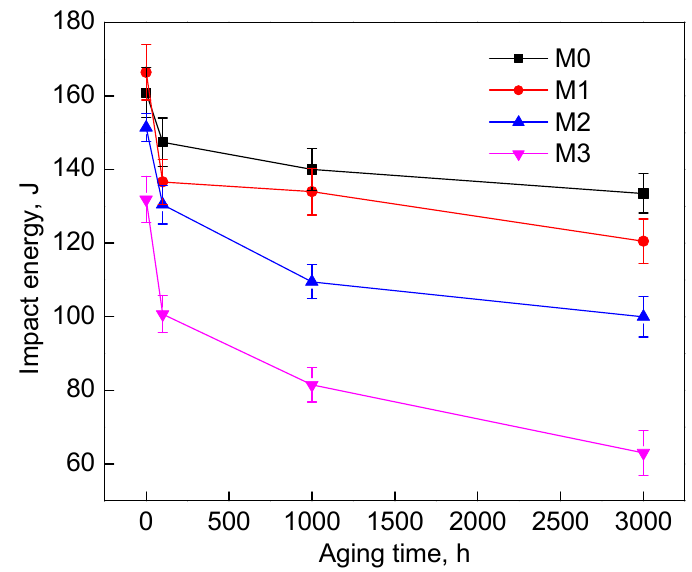
Figure 8. Variation of the impact energies of M0, M1, M2, and M3 steels with aging time.